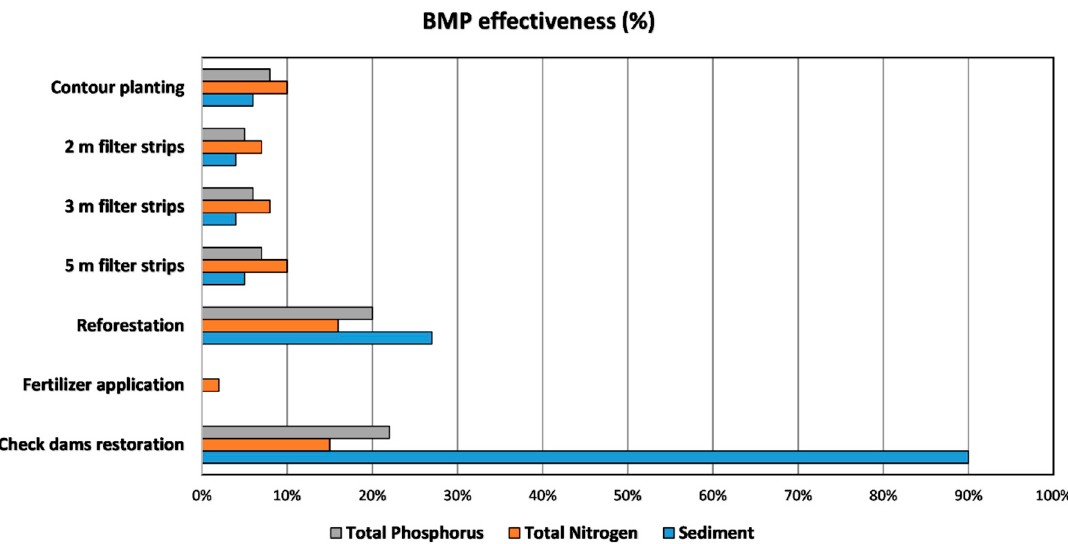
Figure 4. Effectiveness of individual BMPs in sediment and nutrient loadings at the watershed scale.